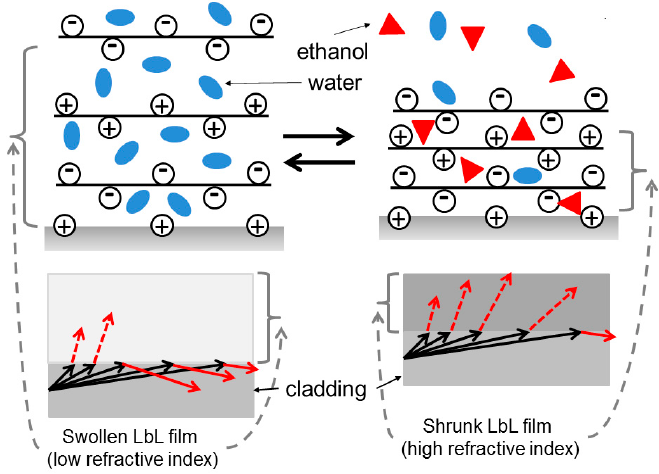
Figure 4. Schematic diagram of the response mechanism of the LbL film to ethanol. (Black solid arrows indicate the propagating light in the cladding. Red solid arrows indicate the reflected light. The dotted red arrows indicate the refracted light.).